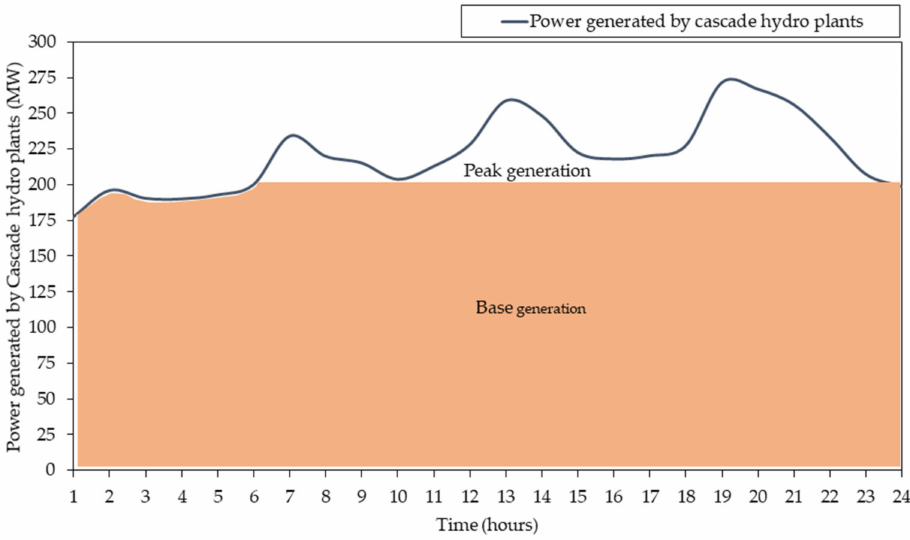
Figure 8. Base and peak generation